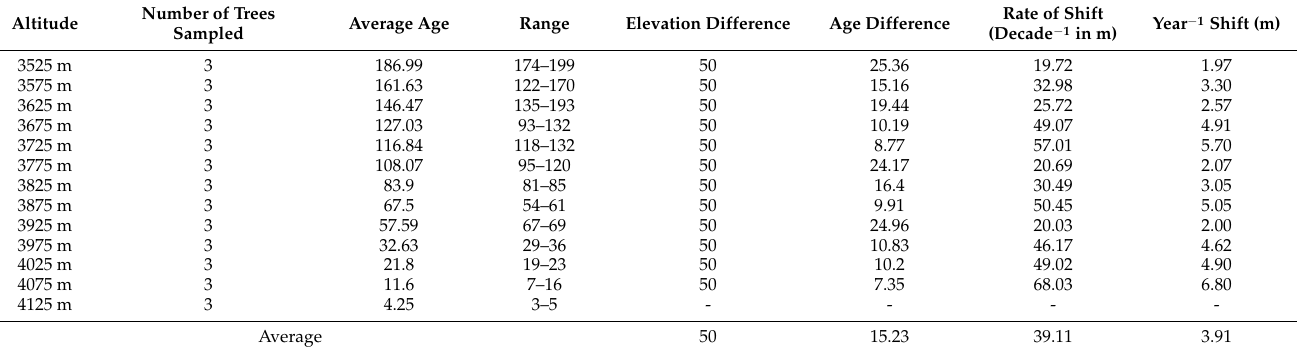
Table 2. Rate of shift of Junipers macropoda in Lahaul Valley of Himachal